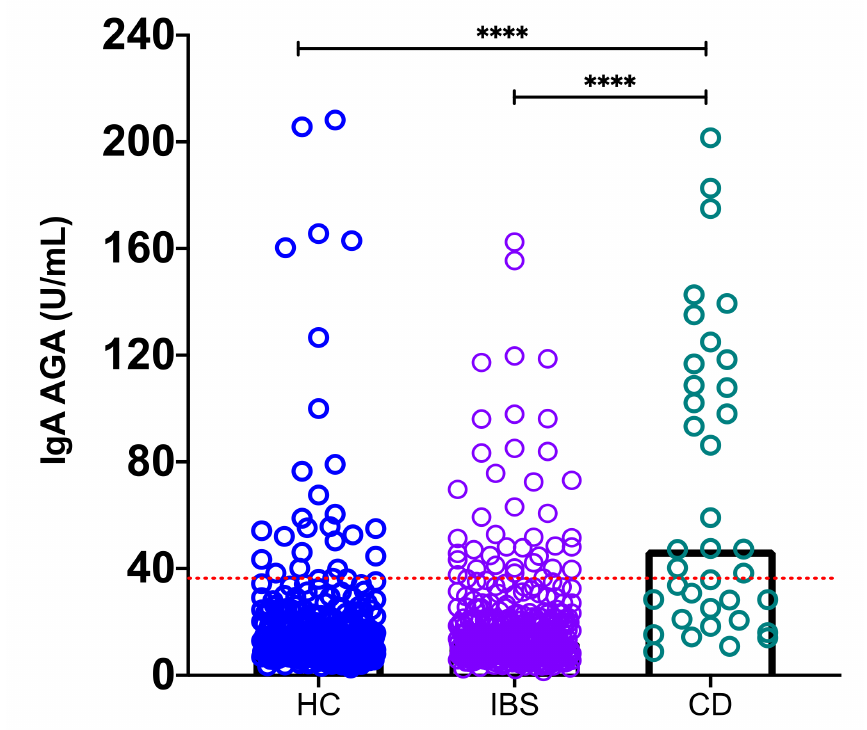
Figure 2. High serum levels of IgA anti-gliadin (AGA) in celiac disease (CD) patients. Cut-off values were calculated and determined as described in the Materials and Methods, and they are shown by dotted lines. Medians values are compared between the groups. **** p